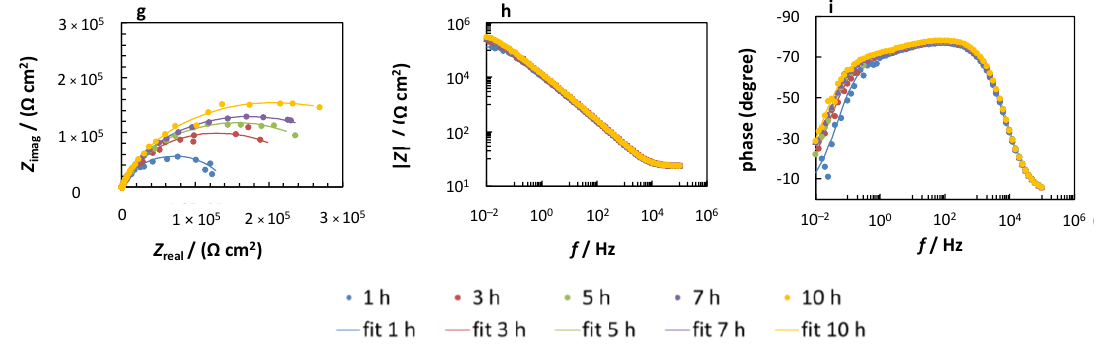
Figure 4. The measured electrochemical impedance spectroscopy (EIS) spectra (dotted) and the respective fitting (in continuous lines) for the AA6082 aluminium alloy samples immersed for 1–10 h, at 25 °C, in ( a – c ) 5 wt.% NaCl solution, ( d – f ) 5 wt.% NaCl solution containing 0.3 mM MBT, and ( g – i ) 5 wt.% NaCl solution containing 0.3 mM MBT with the addition of 0.1 wt.% KI.